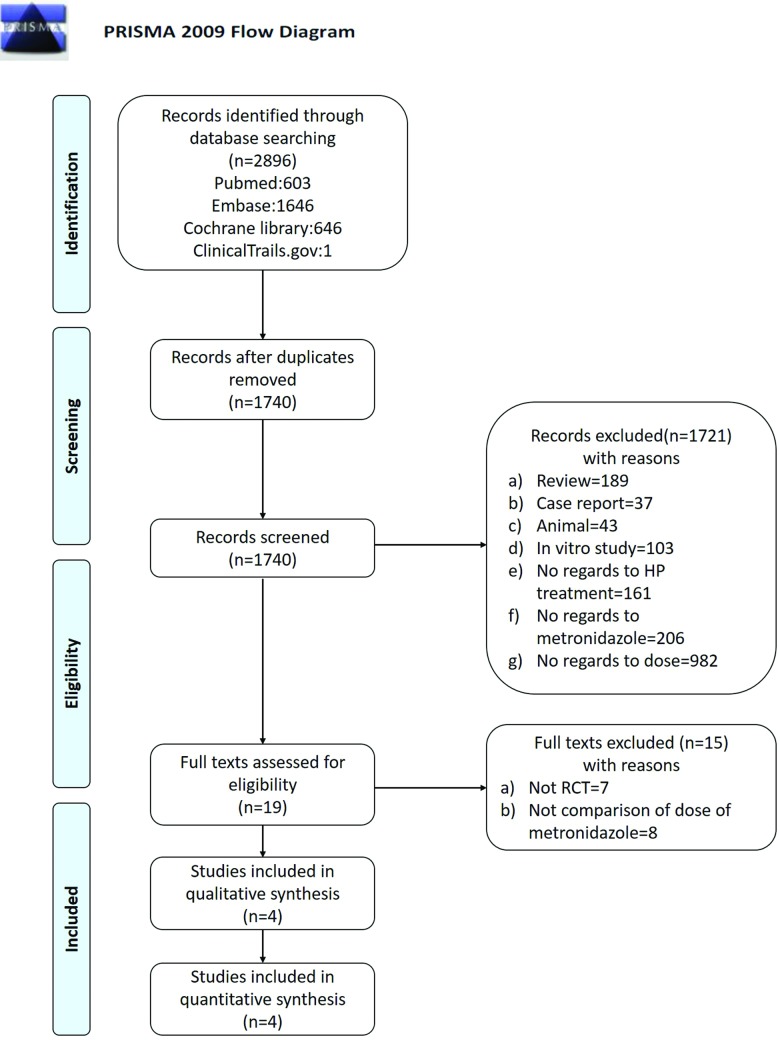
Flow chart of literature review.